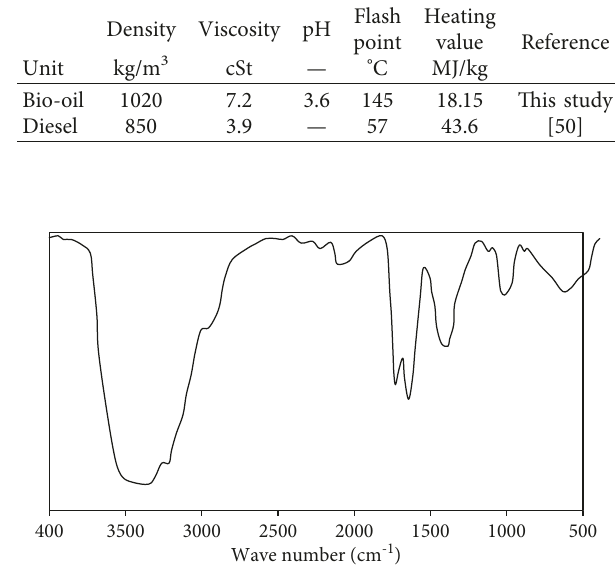
Figure 5: FT-IR analysis of the